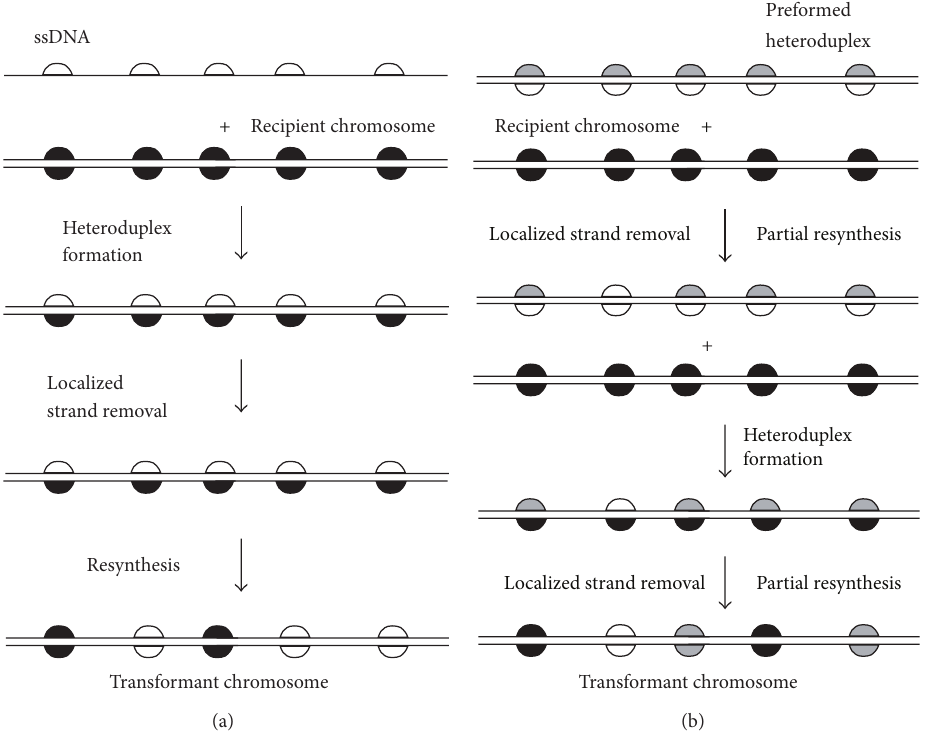
Figure 3: Patchy recombination in Sulfolobus . Cells transformed with linear DNAs marked at multiple sites (or mated with multiply marked donor cells) produce recombinants that indicate erratic, localized strand loss from heteroduplex intermediates [48, 67]. (a) Markers are acquired from ssDNA as multiple short tracts, some of which consist of a single marker. (b) A preformed heteroduplex, containing two distinct donor alleles at each marked position, generates similar short patches representing all three possible alleles. Semicircular symbols depict “silent” genetic markers (synonymous mutations), and the colors (black, white, and gray) depict different alleles. Different colors opposite to each other indicate a mismatch that is eventually resolved by strand removal and resynthesis.